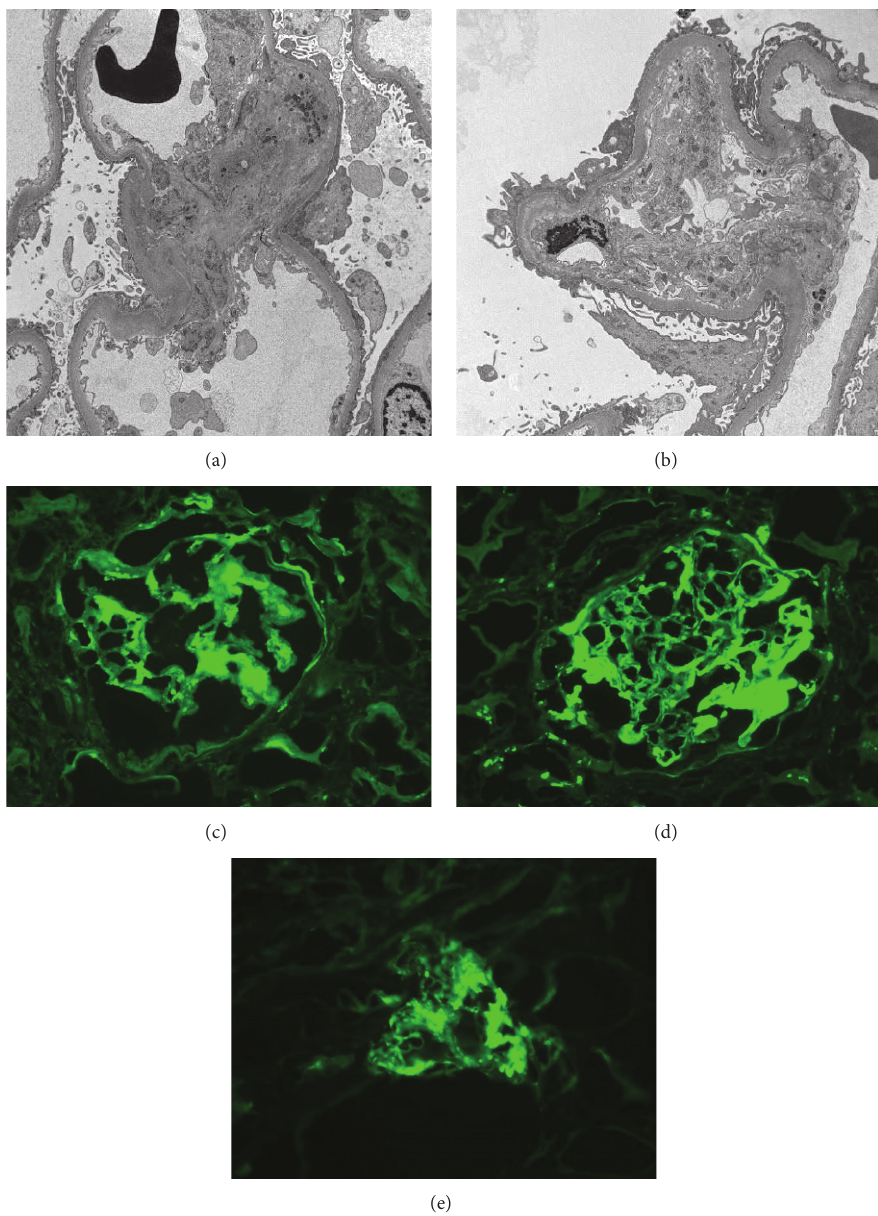
Figure 2: Renal biopsy. Top images (a and b) are electron microscopy slides demonstrating increase in mesangial matrix with segmental mesangial deposits. The glomerular architecture shows corrugation of basement membrane with focal effacement of foot processes. Bottom images are direct immunofluorescence (DIF) showing glomerular staining with C3 (c), fibrinogen (d), and IgA (e), supporting diagnosis of